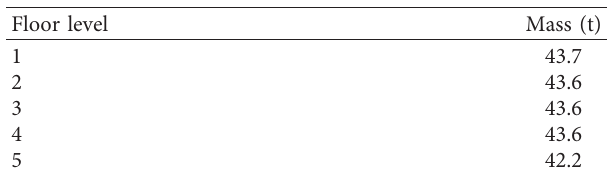
Figure 5: Side view of the case-study building (adapted from Perrone et al. [7]). Table 1: Floor masses.